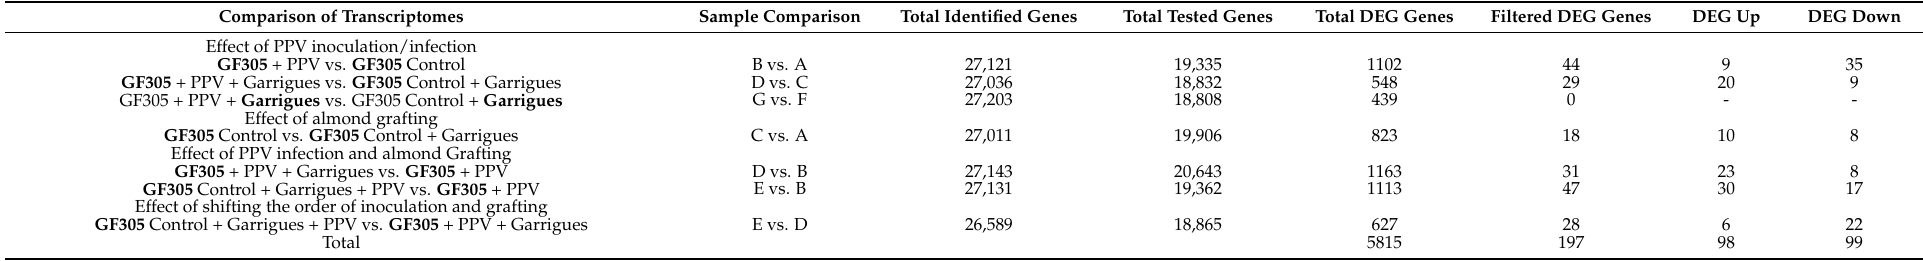
Table 3. Total ( p -value < 0.05) and filtered (q-value < 0.05) differentially expressed genes (DEGs), including the number of up- and down-regulated DEGs in peach and almond genes in the seven comparisons performed comparing control (A) and infected GF305 peach showing strong sharka symptoms (B); control GF305 (C) grafted with Garrigues almond (F) and infected GF305 grafted (D) with Garrigues (G); control GF305 grafted with Garrigues almond and later inoculated with PPV (E). In bold type : the evaluated plant material, GF305 = peach; Garrigues =